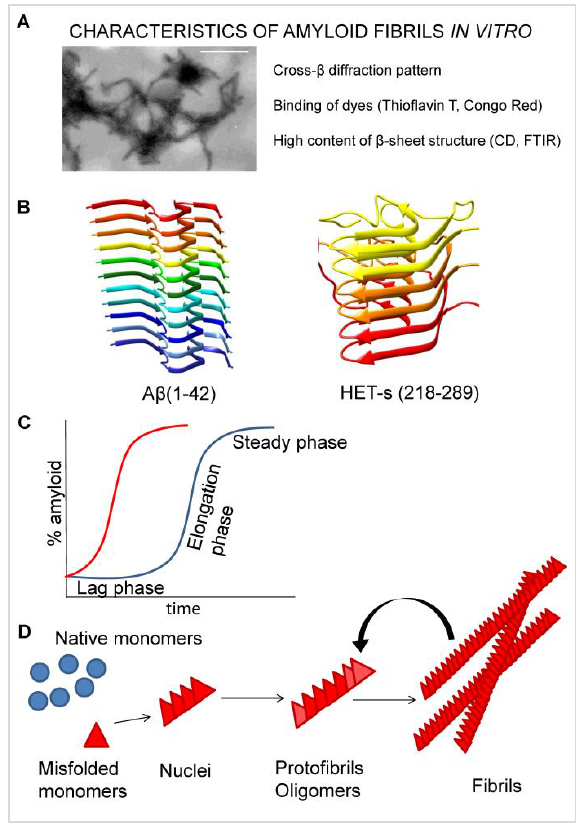
Figure 1: Characteristics of amyloid structure and polymerisation. (A) Amyloid fibrils (fibrils prepared from recombinant prion protein are shown, bar represents 500 nm) can be identified by transmission electron microscopy. Amyloids also have a charac- teristic X-ray diffraction pattern, bind amyloid-selective dyes and have a high content of  -sheet secondary structure, as determined by circular dichroism (CD) or Fourier transform infrared spectroscopy (FTIR). (B) Examples of amyloid structure (A  (1-42), fibril structure (PDB: 2MXU [5],), and HET-s (218-289) structure (PDB: 2KJ3 [6],) deter- mined by solid-state nuclear magnetic resonance. Structural images were generated by use of UCSF Chimera [7]. (C) The kinetics of amyloid formation follow a typical sig- moidal curve (blue). The addition of preformed seeds shortens the lag phase (red curve). (D) A schematic representation of amyloid fibril formation. Misfolded proteins form a nucleus, which is able to capture and transform monomers. In the process of elongation, intermediate structures such as oligomers and protofibrils are formed, which further grow to mature fibrils. Mature fibrils are either spontaneously or enzy- matically disintegrated, providing further perpetuation of amyloid